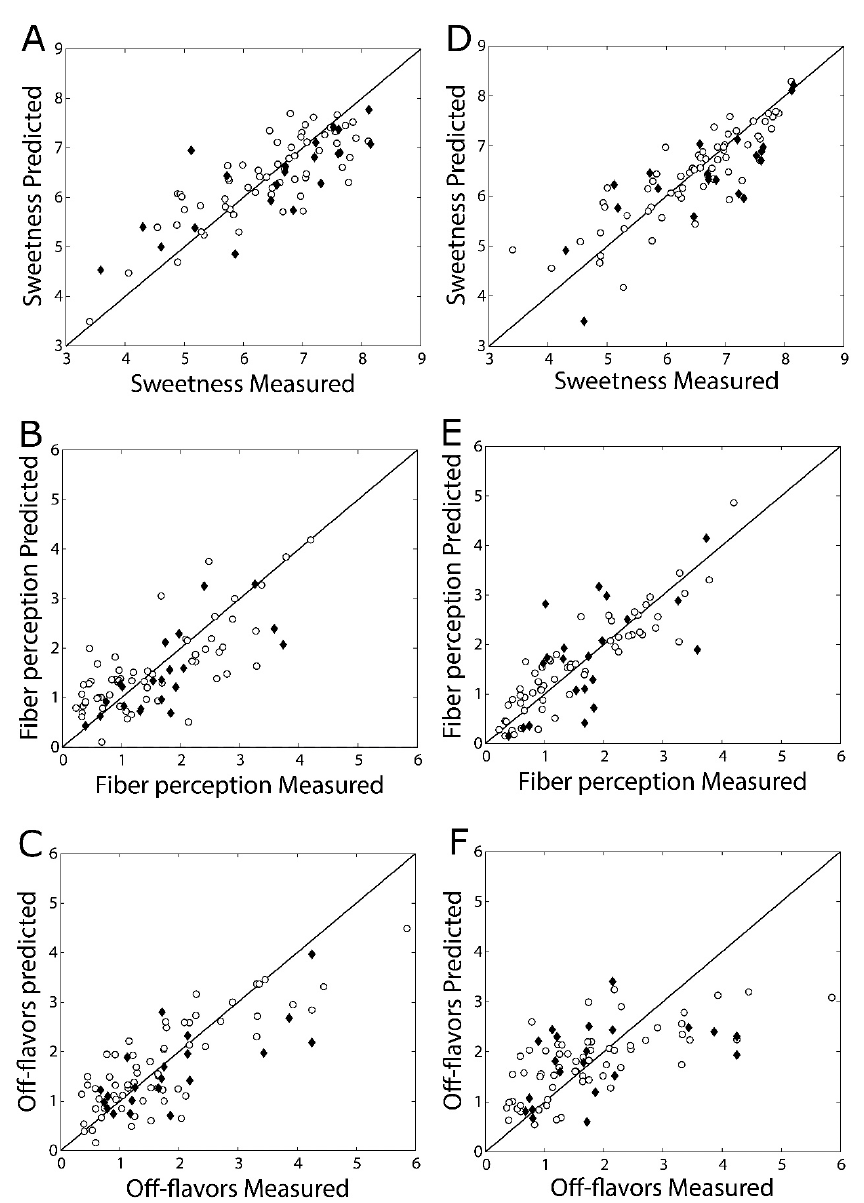
Figure 3. NIRS-predicted versus panel score of sweetness, fiber perception, and off-flavors, using iPLS regression models for puree ( A – C ) and ground dried puree ( D – F ). Black symbols: validation samples, white symbols: calibration samples.